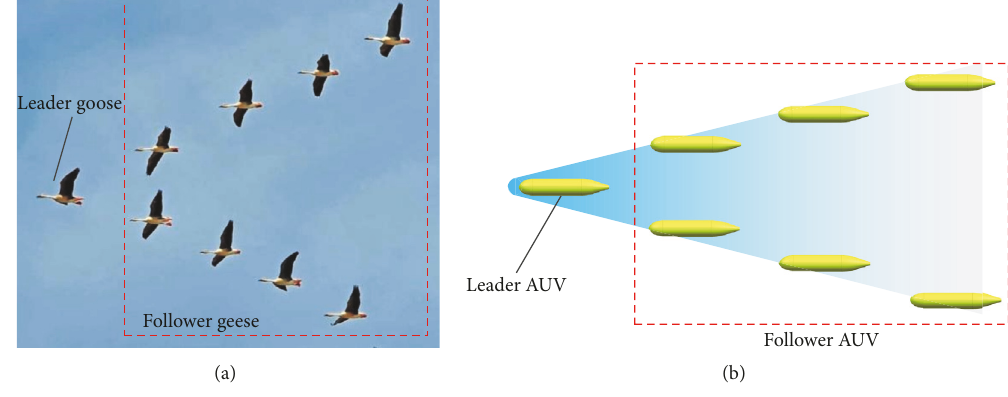
Figure 1: (a) Migrating geese and (b) possible layout of an AUV fleet.